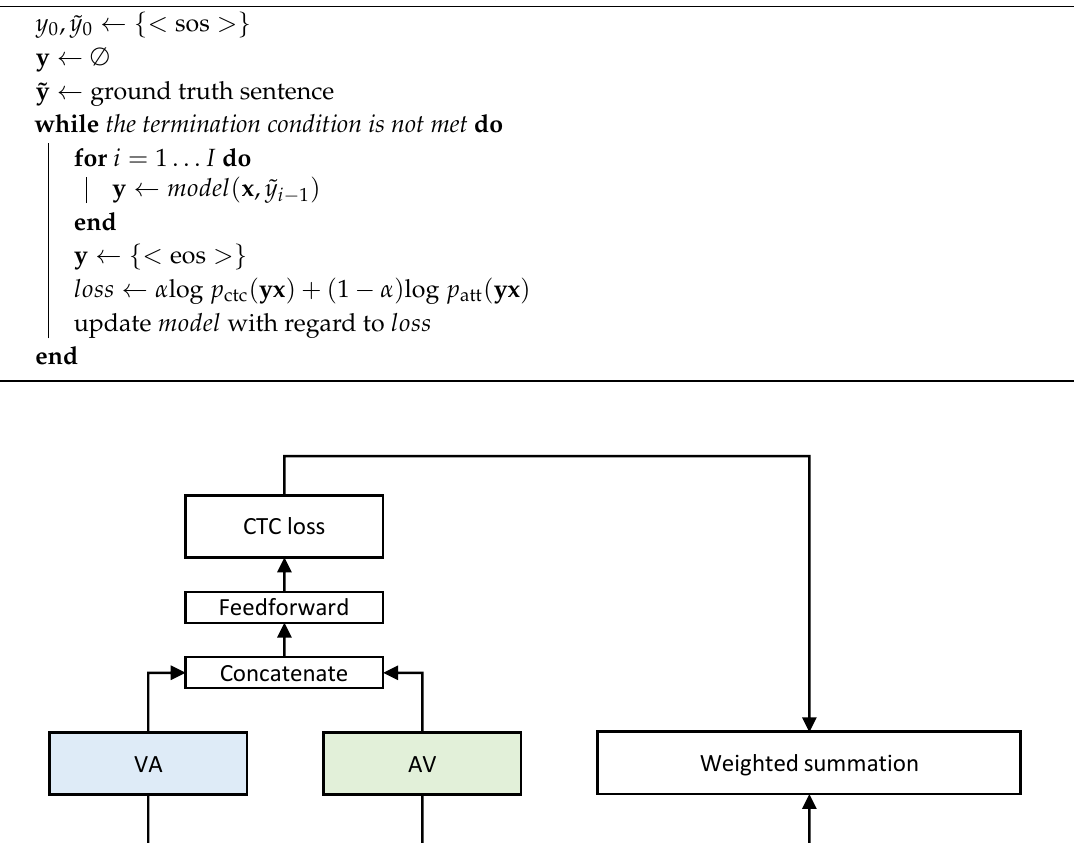
Algorithm 1: Hybrid CTC/attention training